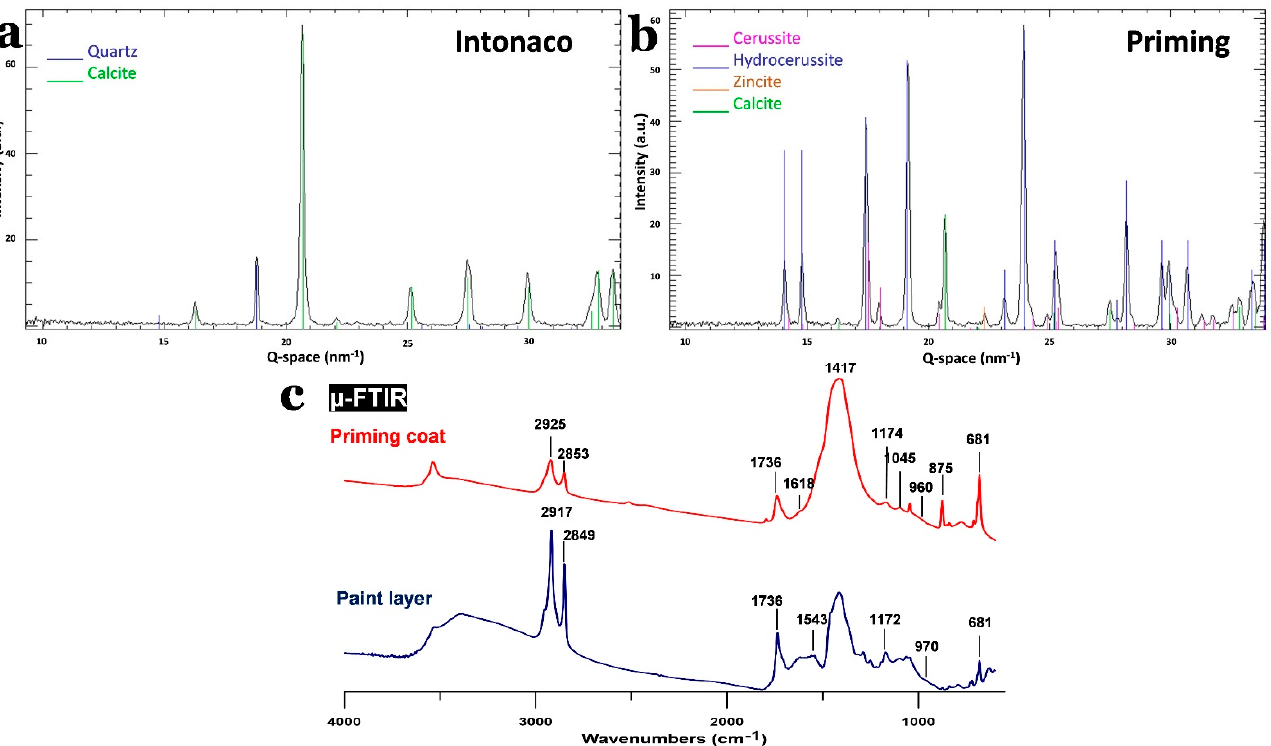
Figure 3. (a ) and ( b ) XRD diffractogram of the intonaco and priming coat, respectively. ( c ) µ-FTIR spectra of the painting and priming coat.